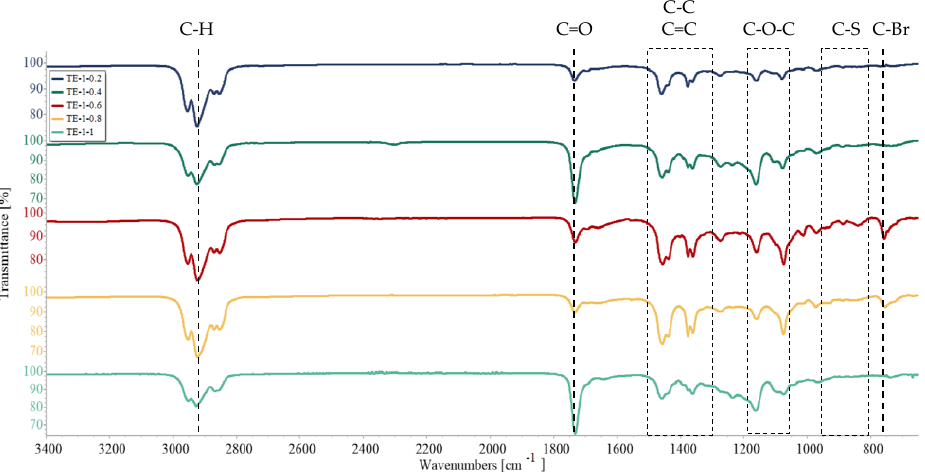
Figure 5. GPC analysis of PEDOT-Br macroinitiators with different synthesis durations.